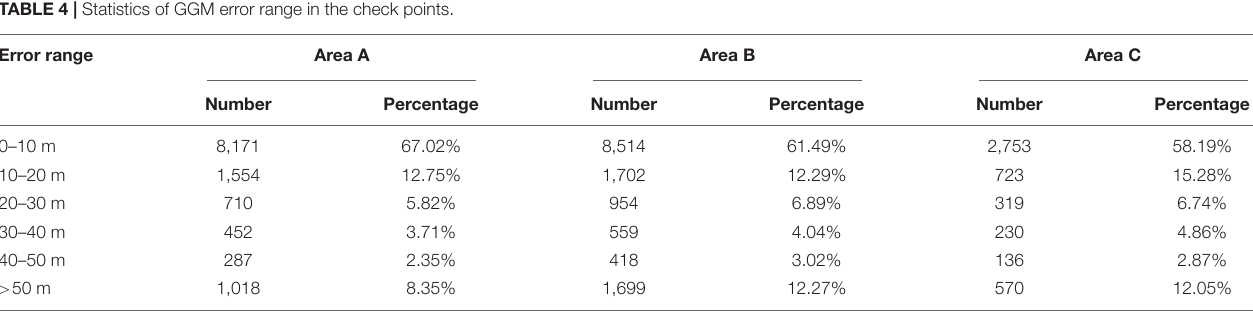
TABLE 4 | Statistics of GGM error range in the check